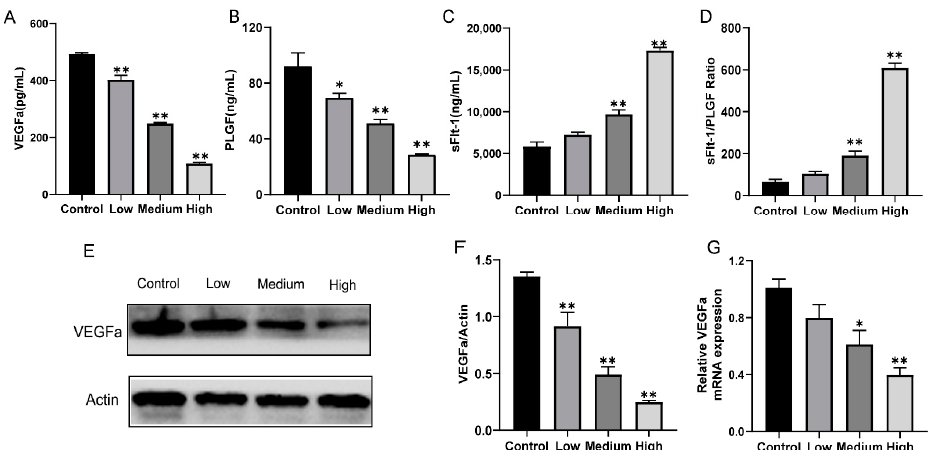
Figure 4. Gestational exposure to cyfluthrin alters levels of the placental anti-angiogenic and anti- angiogenic factors. Pregnant rats were administered corn oil or different doses of cyfluthrin (6.25, 12.5, or 25 mg/kg) daily in pregnancy. Rat serum and placentas were collected on GD19. ( A ) The levels of VEGFa in serum. ( B ) The levels of PLGF in serum. ( C ) The levels of sFlt-1 in serum. ( D ) sFlt-1/PlGF Ratio. ( E ) Western blot image of VEGFa expression. ( F ) Expression levels of VEGFa protein. ( G ) Expression levels of VEGFa mRNA. Values are expressed as the mean ± SE. The result was analyzed with one-way ANOVA followed by Dunnet’s t -test. * P < 0.05, ** P < 0.01 compared to controls.